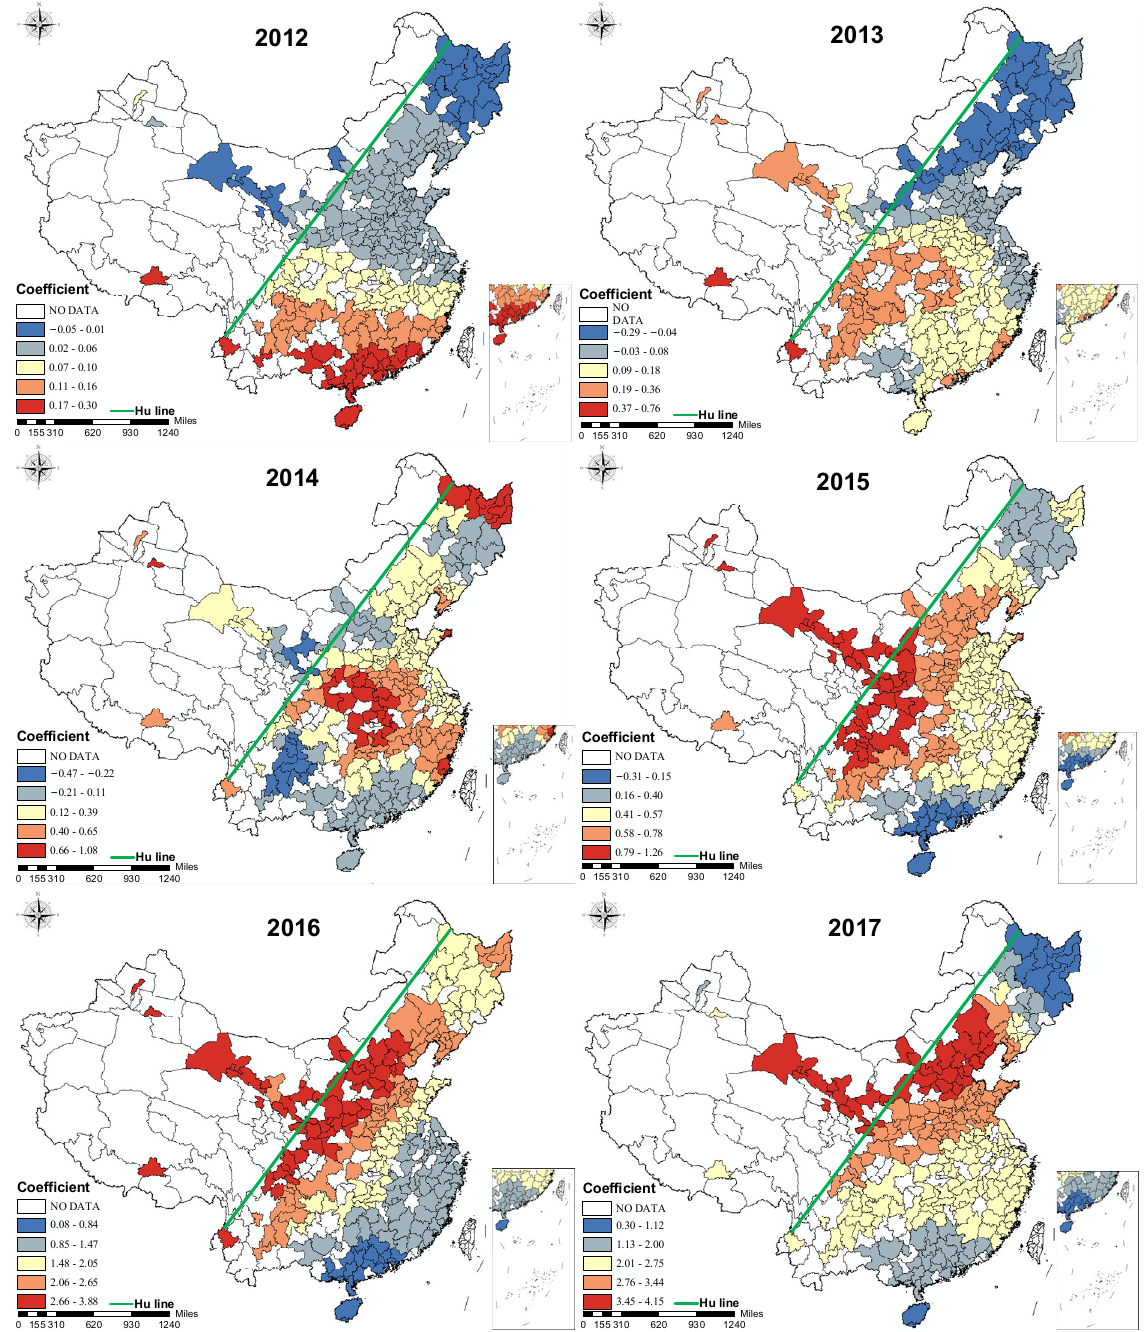
Figure 6. The spatial coefficient distribution for students in regular institutions of higher education from 2012 to 2017 based on the GWR model. (Note: A positive coefficient means a positive association between an increasing proportion of students in regular institutions of higher education (NS_RIHE) and more inferiority, while the negative coefficient is the opposite.).